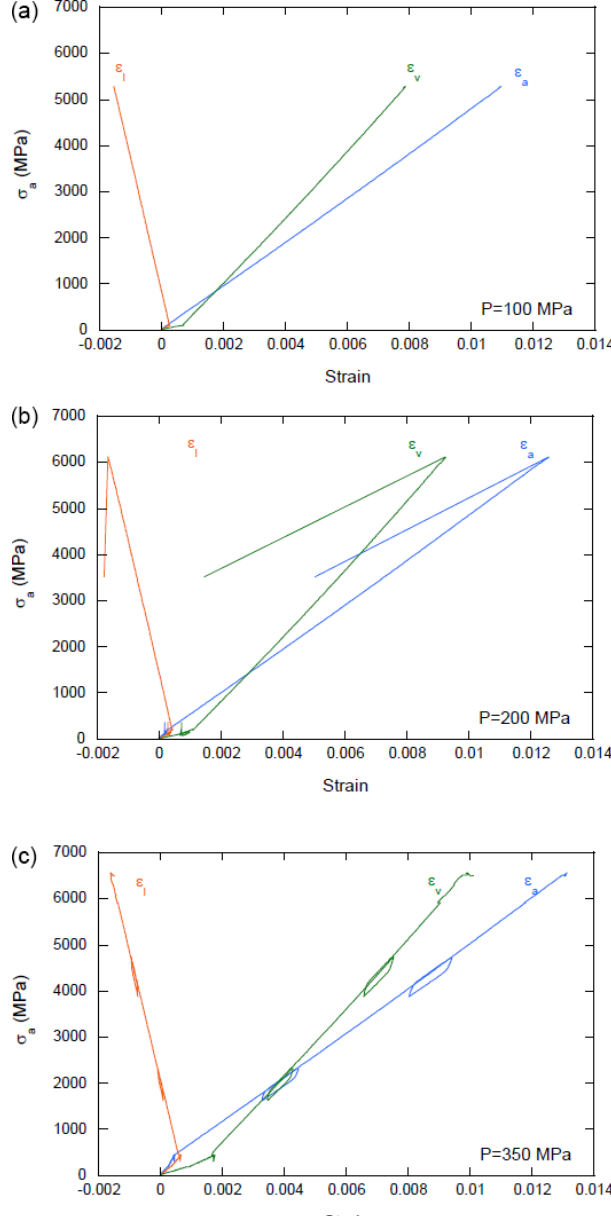
Figure 4. Triaxial stress-strain curves at different confining pres- sures P = 100MPa (a) , 200MPa (b) , and 350MPa (c) ; ε l : circum- ferential, ε v : volumetric, ε a : axial (Lee et al., 2005).